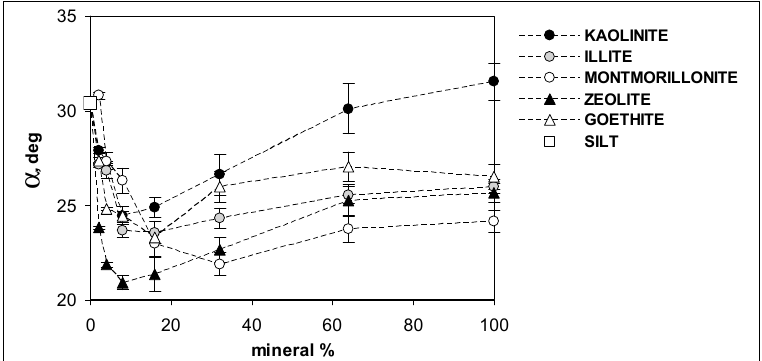
Figure 6. Dependence of the contact angle on the added minerals’ percentage. Error bars are standard deviations.